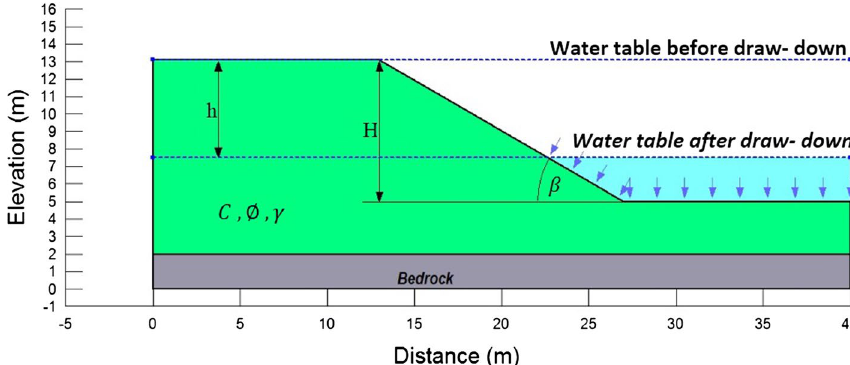
Fig. 1 A schematic representa- tion of the simulated model and the studied